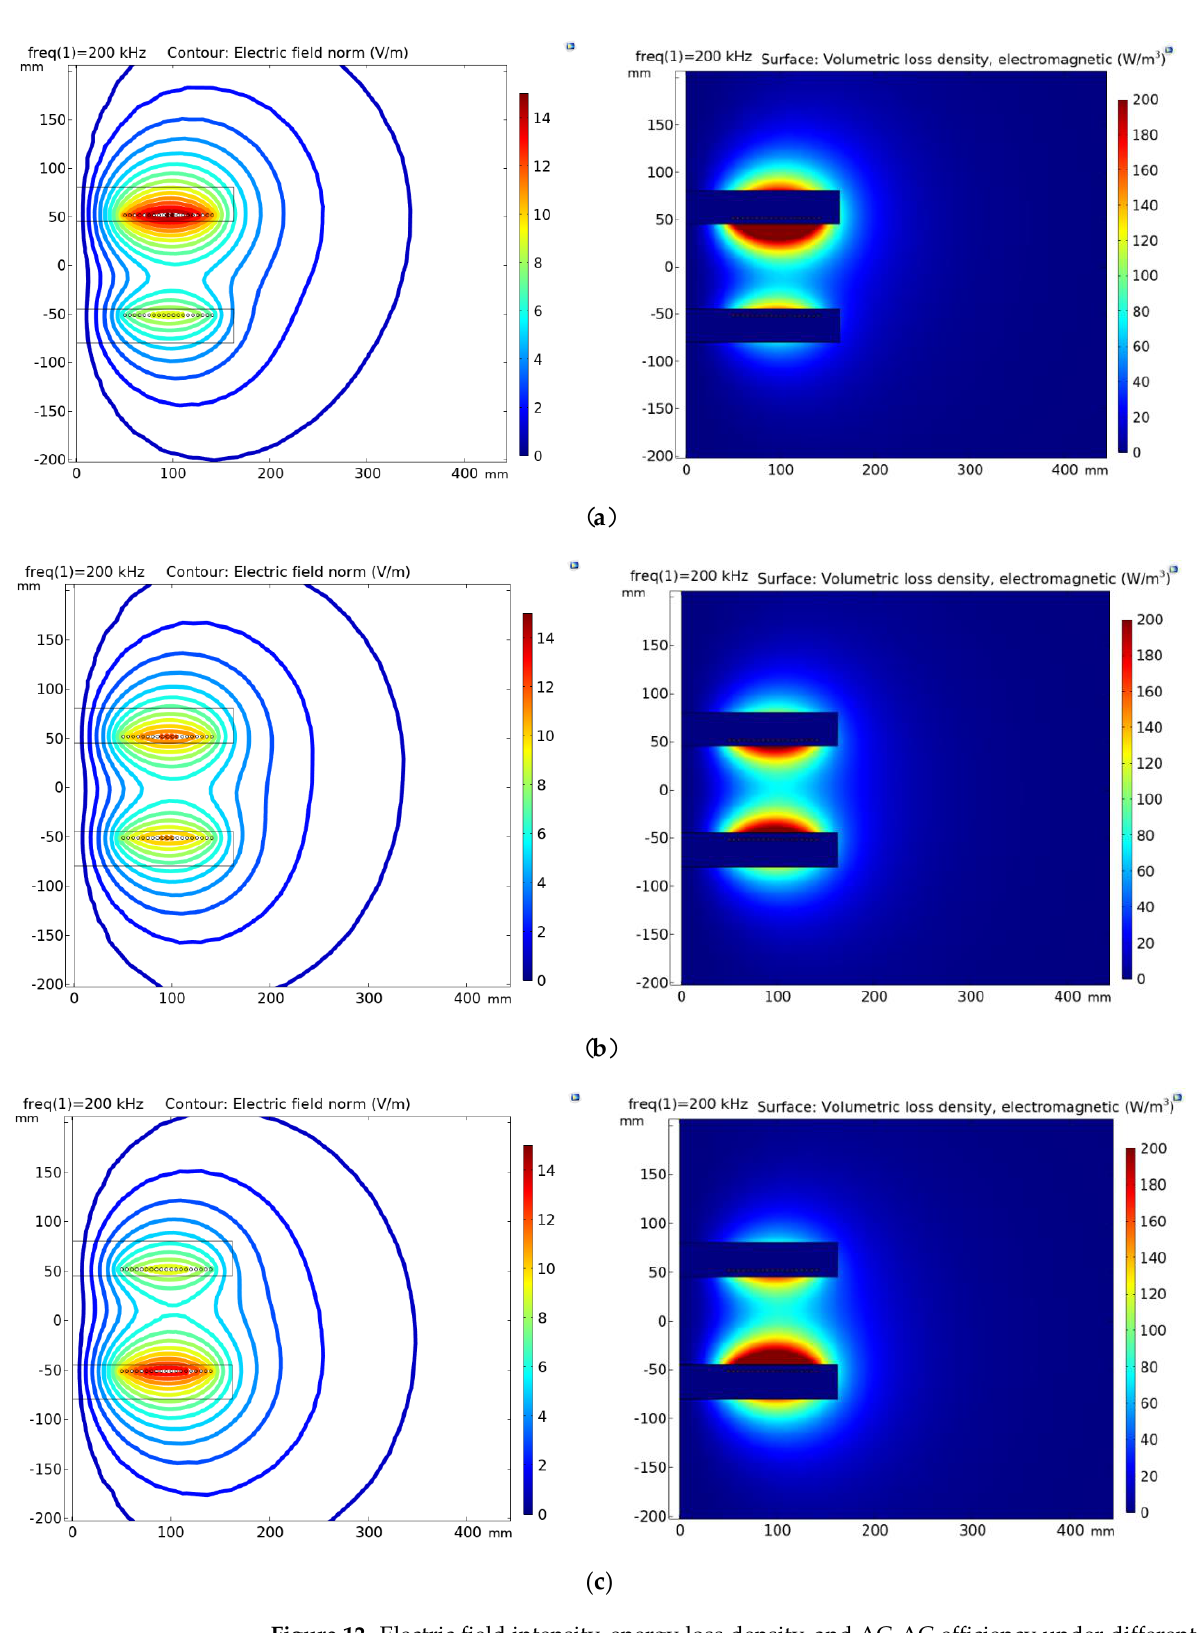
Figure 12. Electric field intensity, energy loss density, and AC-AC efficiency under different modu- lus ratios when f = 200 kHz, α 0 = 1.1068. ( a ) α/α 0 = 0.60, η = 0.7837; ( b ) α/α 0 = 0.99, η = 0.8343; ( c ) α/α 0 = 1.33, η = 0.8114.